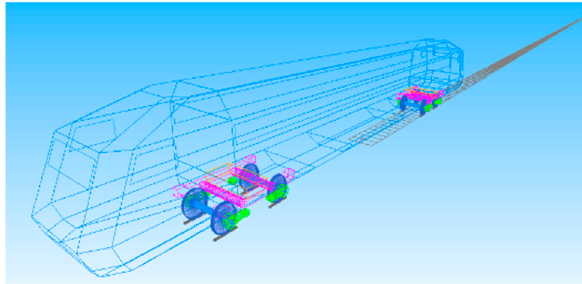
Figure 8. The numerical model. Table 2. Critical parameters of high ‐ speed train.